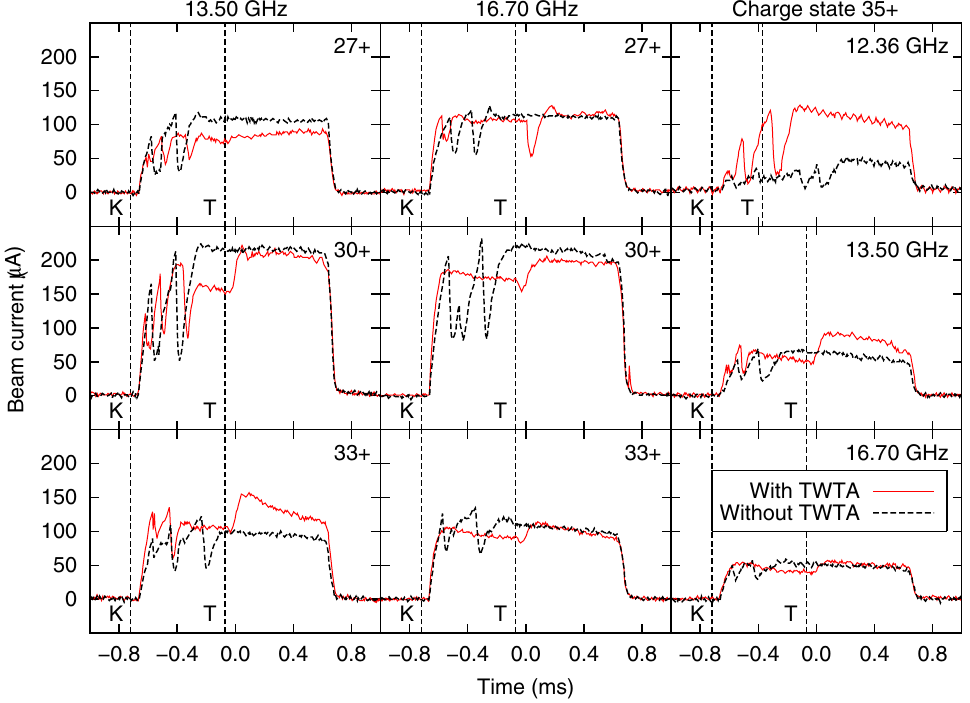
FIG. 13. Beam currents of selected lead ion charge states with single and double frequency heating. With double frequency heating a fixed delay of 0.65 ms (0.35 ms for the Pb 35 þ at 12.36 GHz case) was used between the trailing edges of the primary (K) and secondary (T) frequency pulses. The first and second columns presents charge states 27 þ , 30 þ , and 33 þ with 13.50 and 16.70 GHz secondary frequencies. The third column presents charge state 35 þ with frequencies 12.36, 13.50, and 16.70 GHz. The TWTA output power with the frequencies 12.36, 13.50, and 16.70 GHz were 180, 200, and 185 W, Fig. 13, only minor differences are observed between the beam current levels of single and double frequency operation after both microwave sources have switched